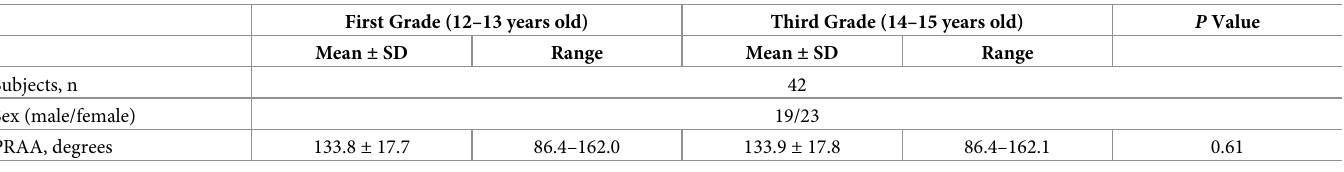
Table 3. PRAA of junior high school subjects of the RVS(+) group while they were in the first grade and the third